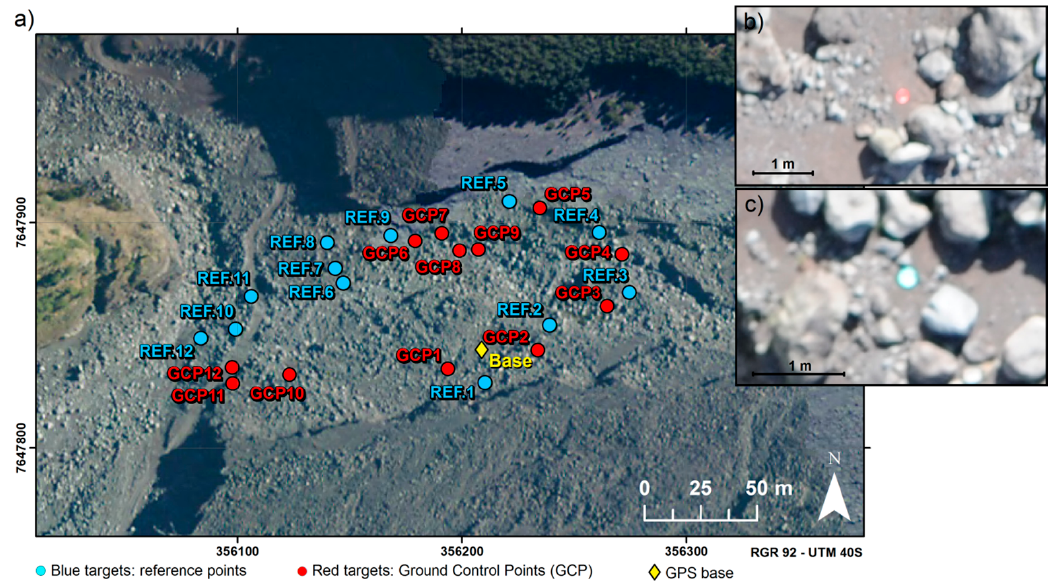
Figure 3. ( a ) Location map of the targets. Red targets are Ground Control Points (GCPs) used in the Structure from Motion (SfM) photogrammetry process. Blue targets are reference points (REF) used for quantifying the accuracy of the results. (Background is an extract from the BD Ortho ® —IGN © , 2008); ( b , c ) are examples of the targets as captured in the images.